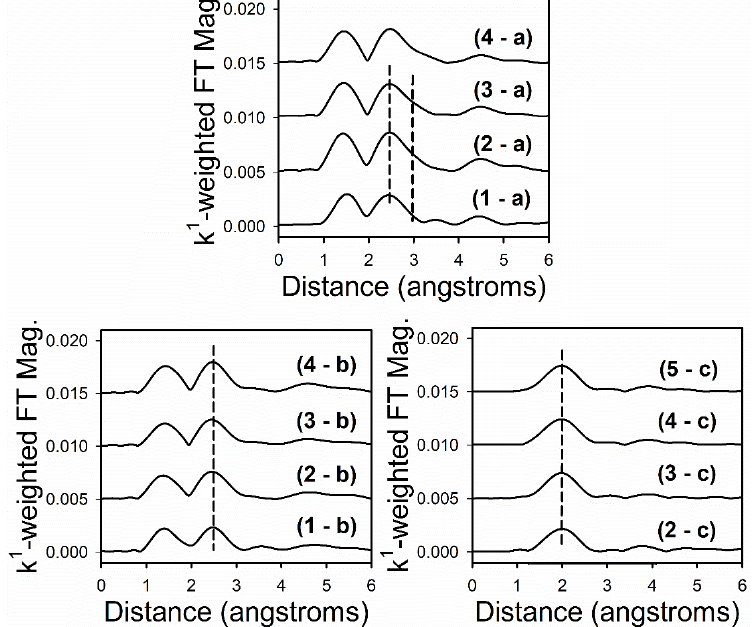
Figure 17. Ni K-edge EXAFS spectra: ( a ) the initial point consisting of primarily NiO associated with Co 3 O 4 ; ( b ) the point consisting of primarily NiO associated with CoO; and ( c ) the final spectrum consisting of primarily Ni 0 for ( 2 ) 25%M (M = 5%Ni-95%Co)/Al 2 O 3 , ( 3 ) 25%M (M = 10%Ni-90%Co)/Al 2 O 3 , ( 4 ) 25%M (M = 25%Ni-75%Co)/Al 2 O 3 , and ( 5 ) 25%M (M = 50%Ni-50%Co)/Al 2 O 3 .